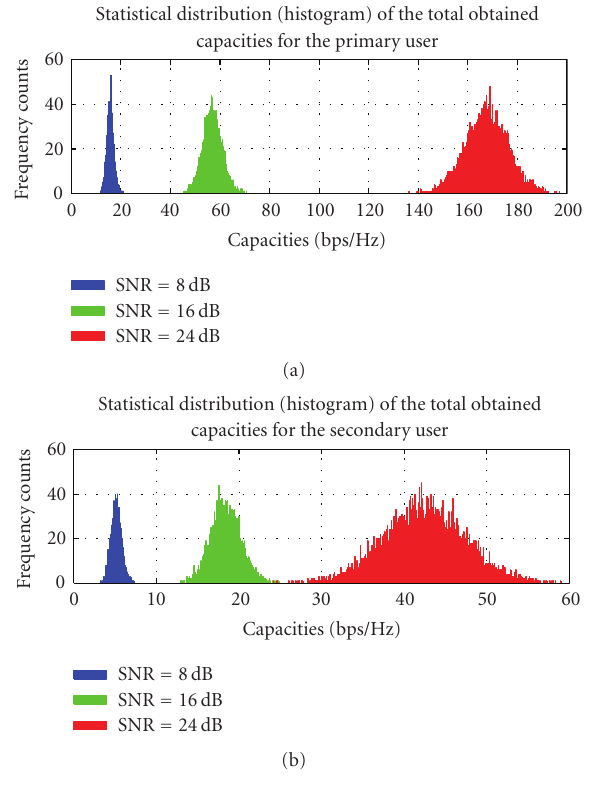
Figure 4: Histograms of the total obtained capacities (primary/ secondary user), SNR = 8dB, 16dB, and 24